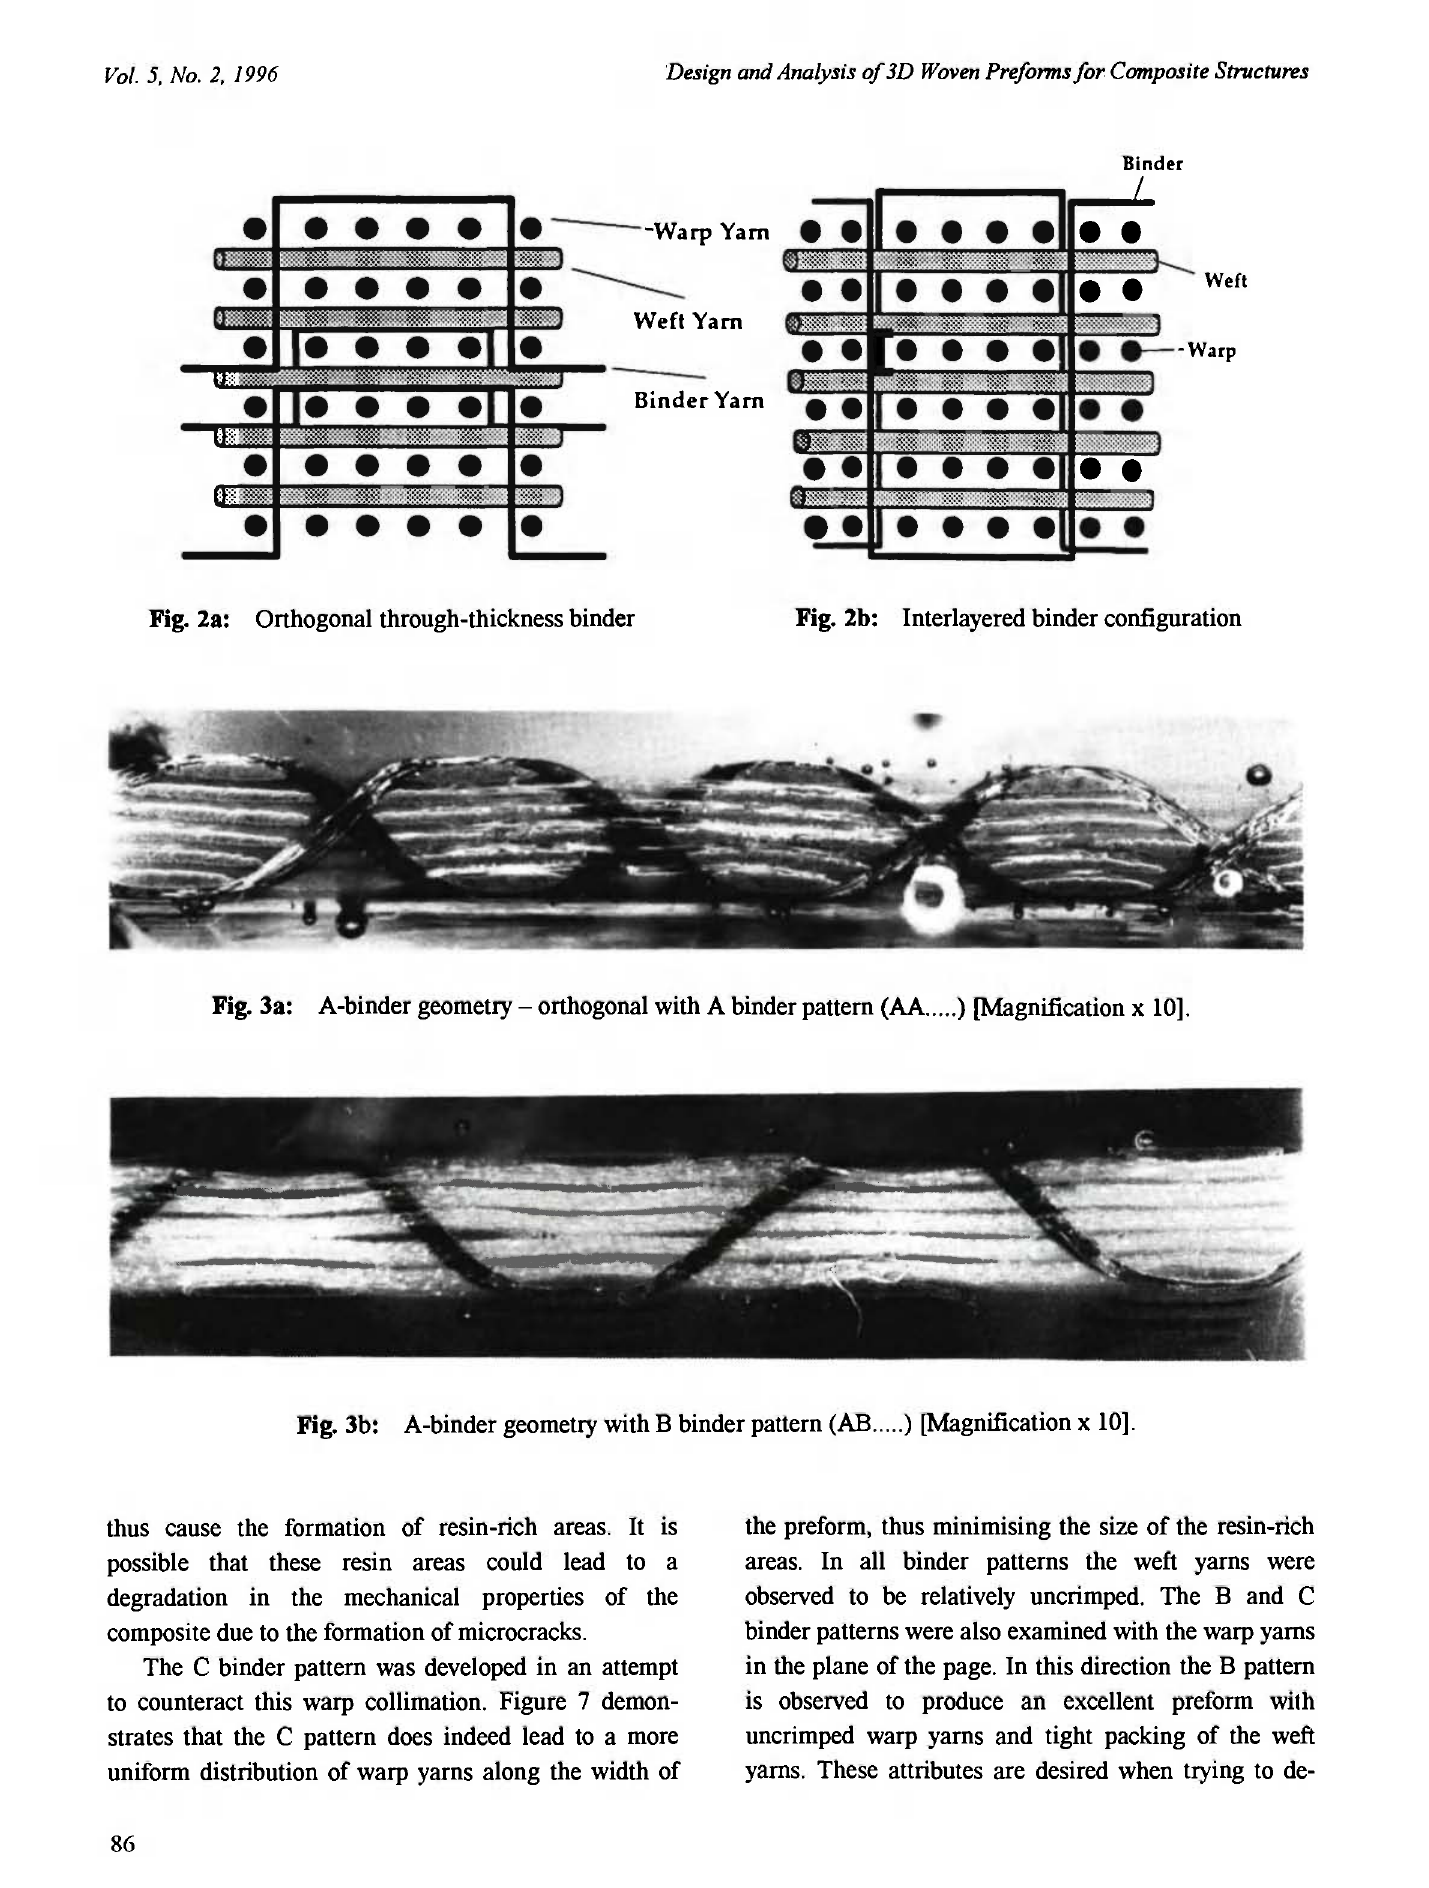
Fig. 2a: Orthogonal through-thickness binder Fig. 2b: Interlayered binder configuration